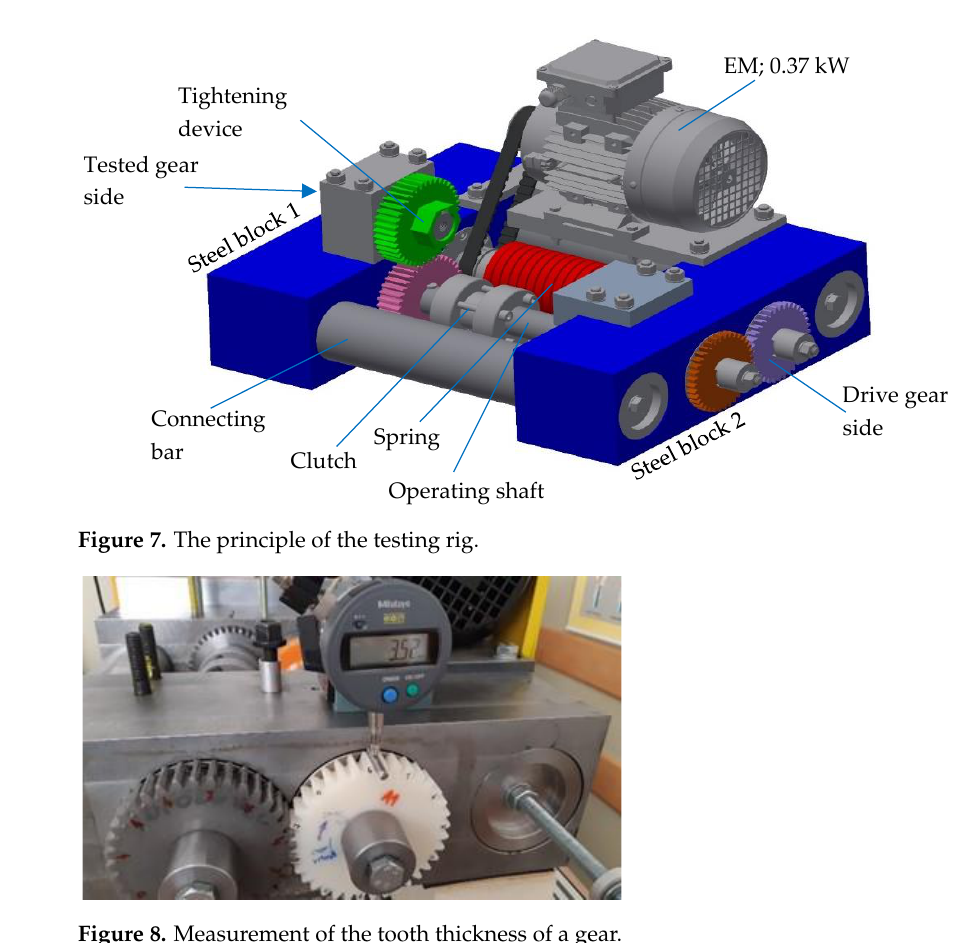
Figure 8. Measurement of the tooth thickness of a gear.